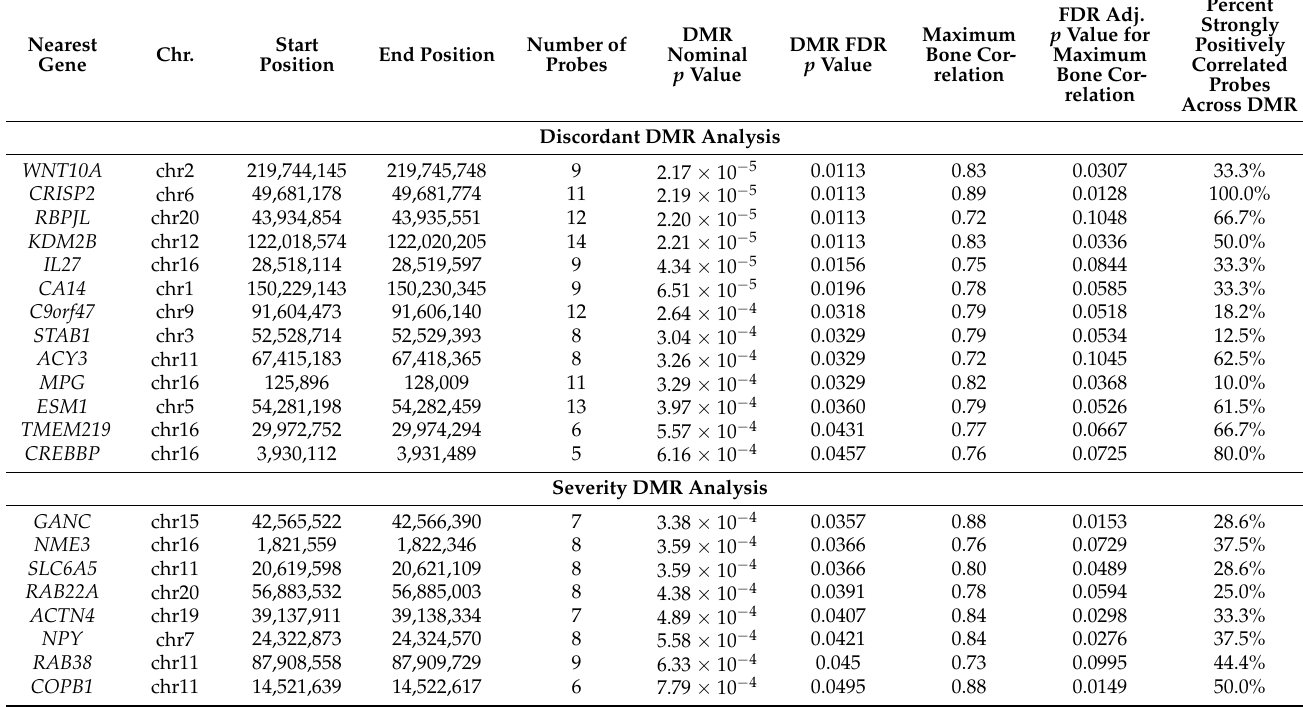
Table 2. Priority DMRs Based on High Correlation with